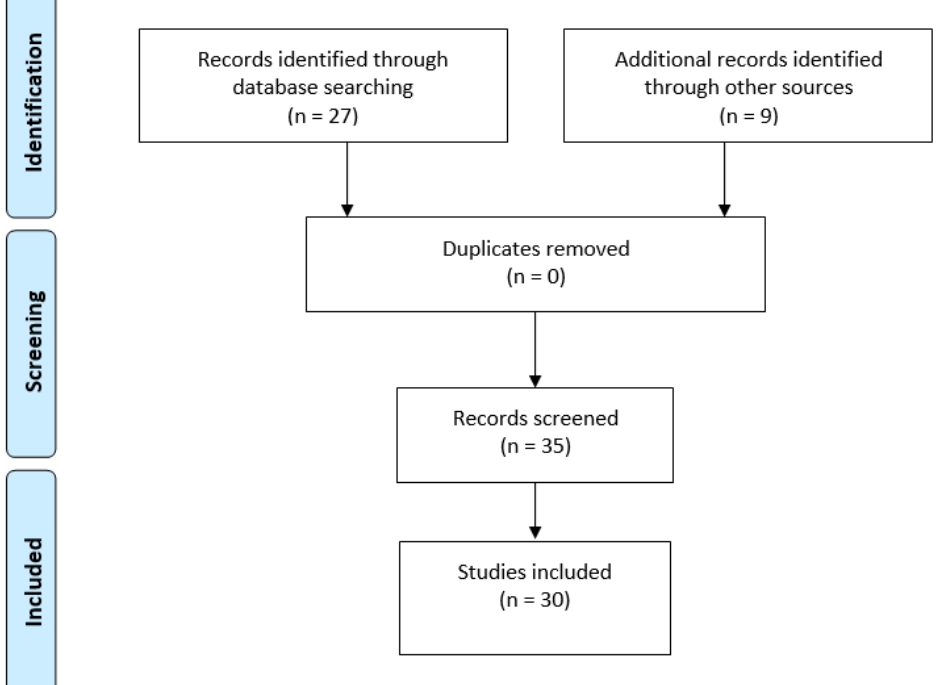
Figure 3. Overview of studies identified in the steps of the systematic review process derived from the PRISMA flow diagram [72] .